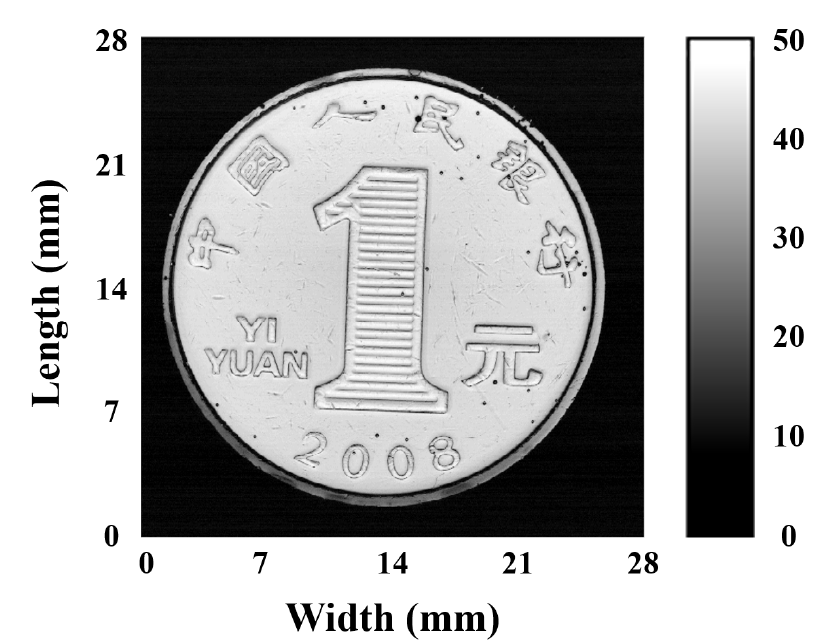
Figure 9. C-mode scanning images of the RMB coin.